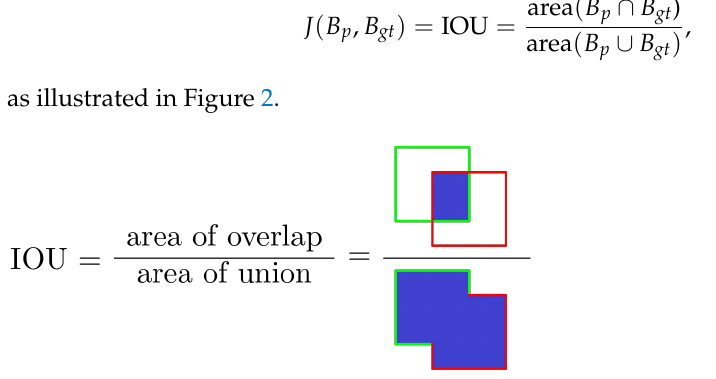
Figure 2. Illustration of the intersection over union